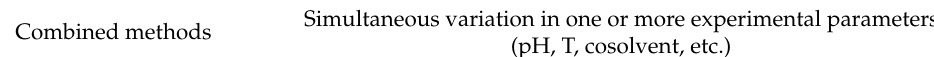
Table 4. Main effects of changes in the solvent phase that affect partitioning. Cosolvents Modification of the dielectric constant Formation of complexes, modification solvent structure, and/or Hydrotopes self-agregation to form “micelle-like” aggregates Micelles Modifications of the propertiesLiposomes Creation of one or more regions with different solvent solvent phase Microemulsions Emulsions Complexation Formation of host-guest complexes Simultaneous variation in one or more experimental parameters Combined methods (pH, T, cosolvent,